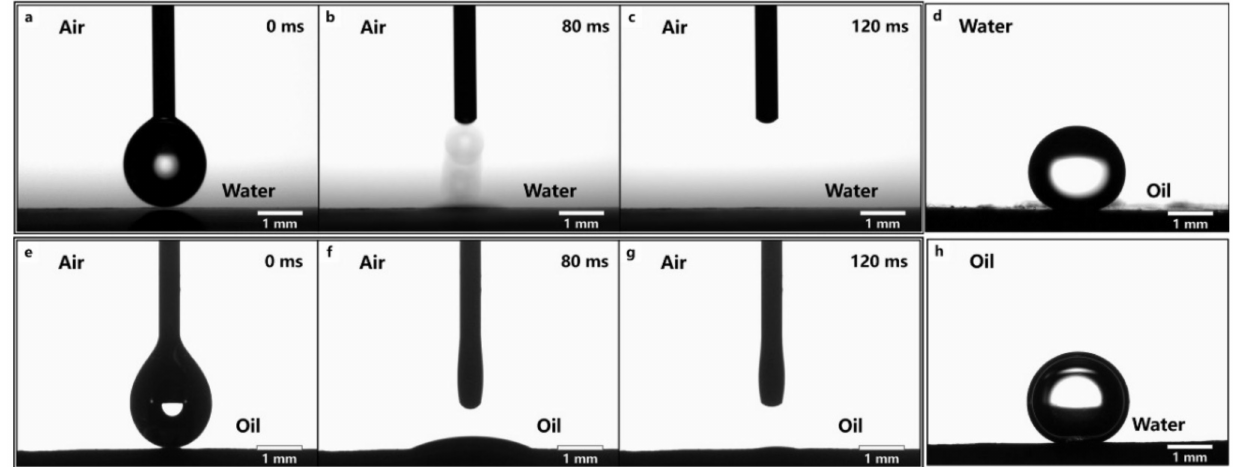
Figure 5. ( a – c ) Imaging of a water droplet spreading through coated filter membrane; ( d ) imaging of an underwater oil droplet on a filter membrane with a 151.4 ◦ contact angle; ( e – g ) imaging of oil droplets spreading through coated filter membrane; ( h ) imaging of an underoil water droplet on a filter membrane with a 152.7 ◦ contact angle.